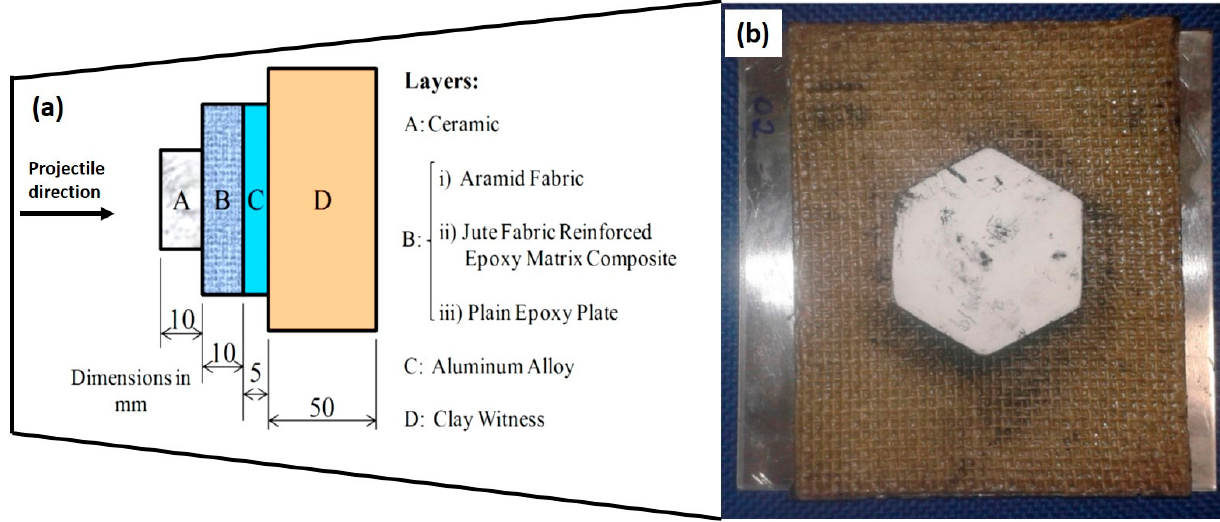
Figure 15. ( a ) Schematic diagram of the multi-layered armor system (MAS) that consist of jute fabric reinforced with epoxy, and ( b ) real composite sample. (Adapted with copyright permission from Da Luz et al. [134]).